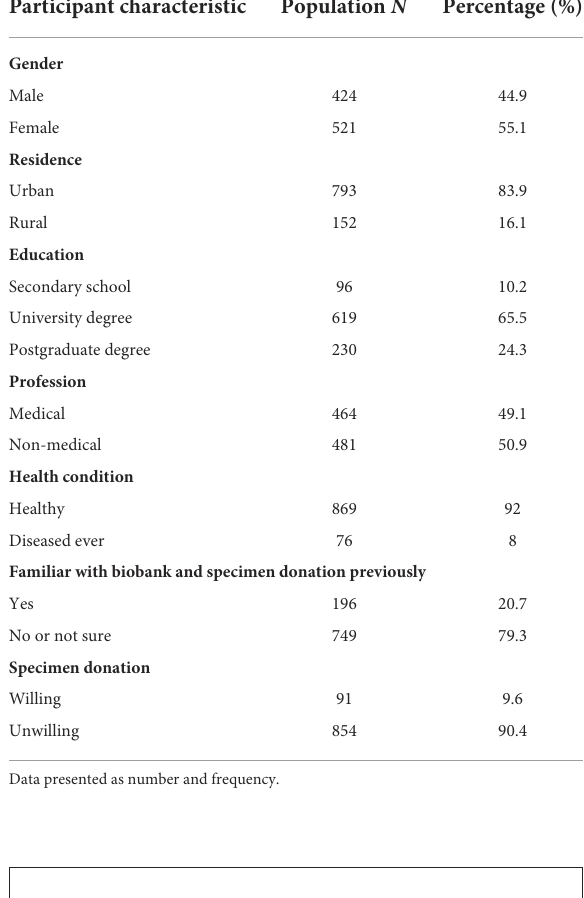
the lecture on biobanks ( P < 0.001). A comparison of the effectiveness of the three methods in raising willingness to donate revealed that text-based publicity and lecture-based publicity were more effective than picture-based material publicity ( P = 0.001), with the highest increase in donation rate observed in participants who received lecture-based publicity (Figure 1). The details are shown in Table